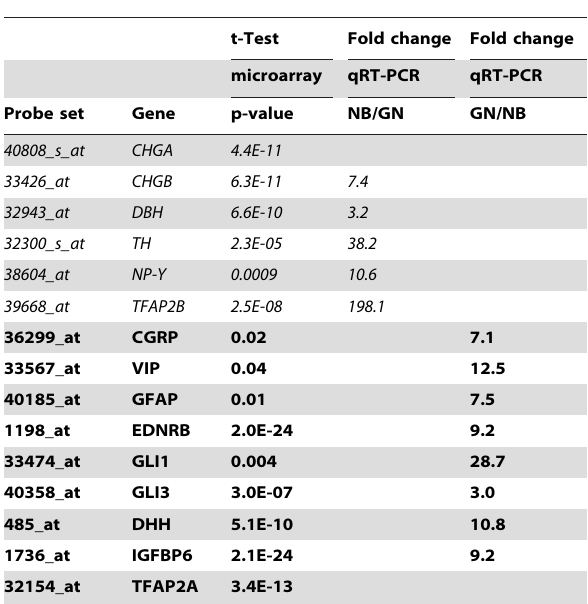
Table 1. Measured abundance of mRNA for select